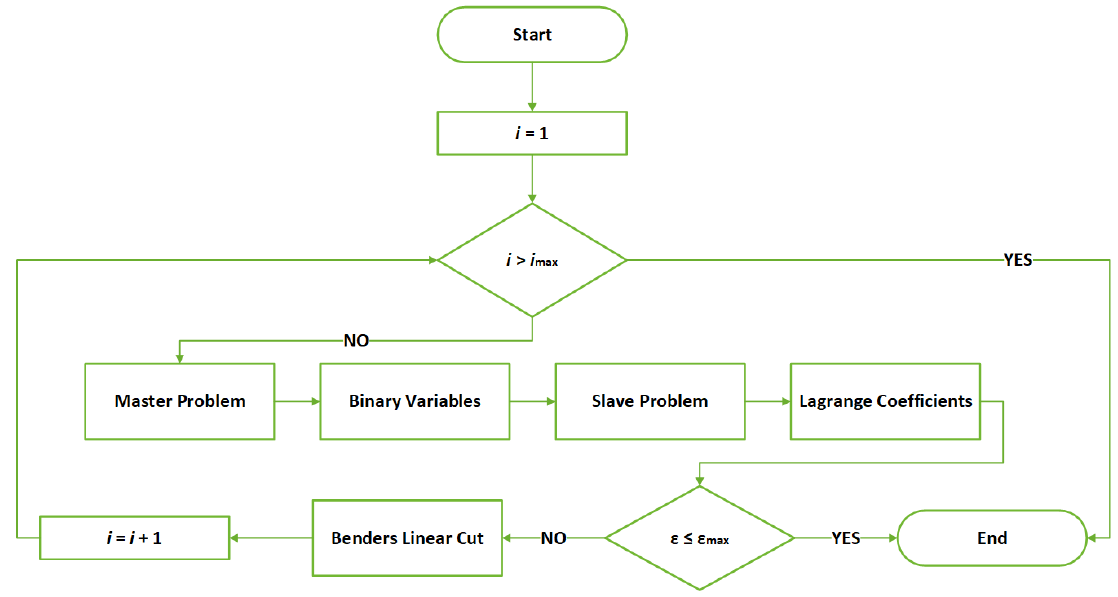
Figure 3. The Benders decomposition